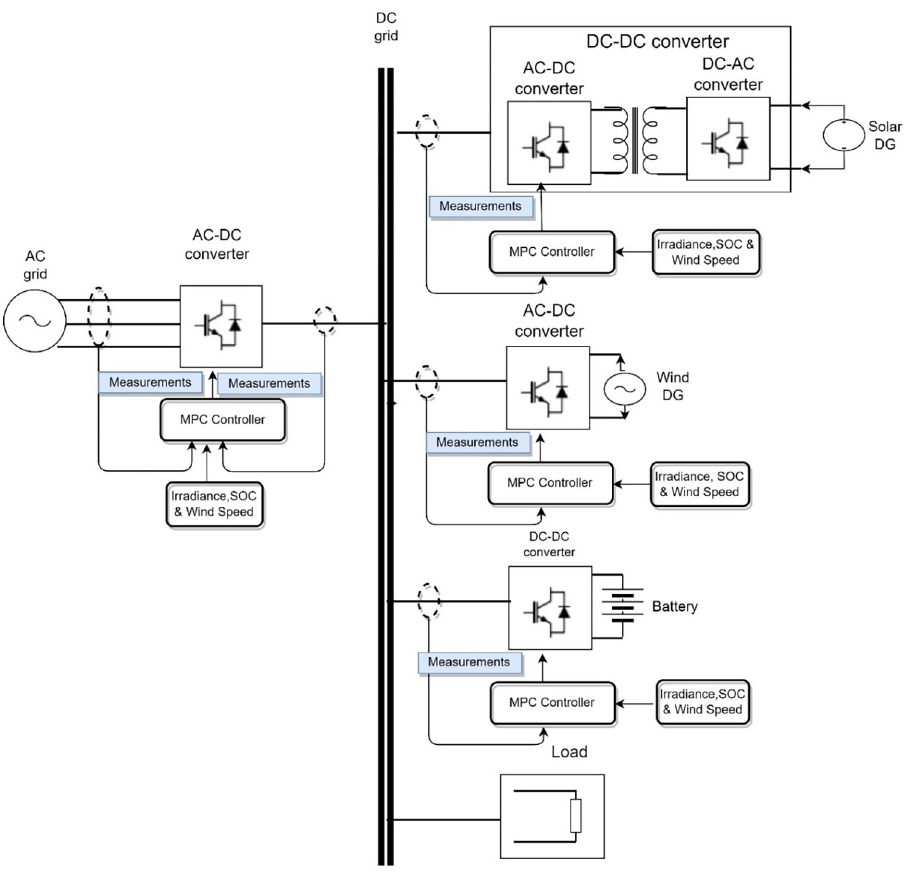
Fig 2. DC microgrid with DRES, BESS, AC/DC converter and